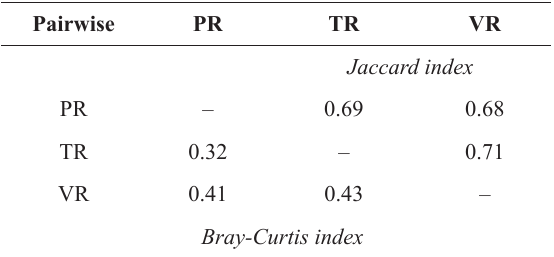
Pairwise similarities index of parasite component community of Leporinus friderici from three upstream tributaries of Jurumirim reservoir, Upper Paranapanema River, southeast,